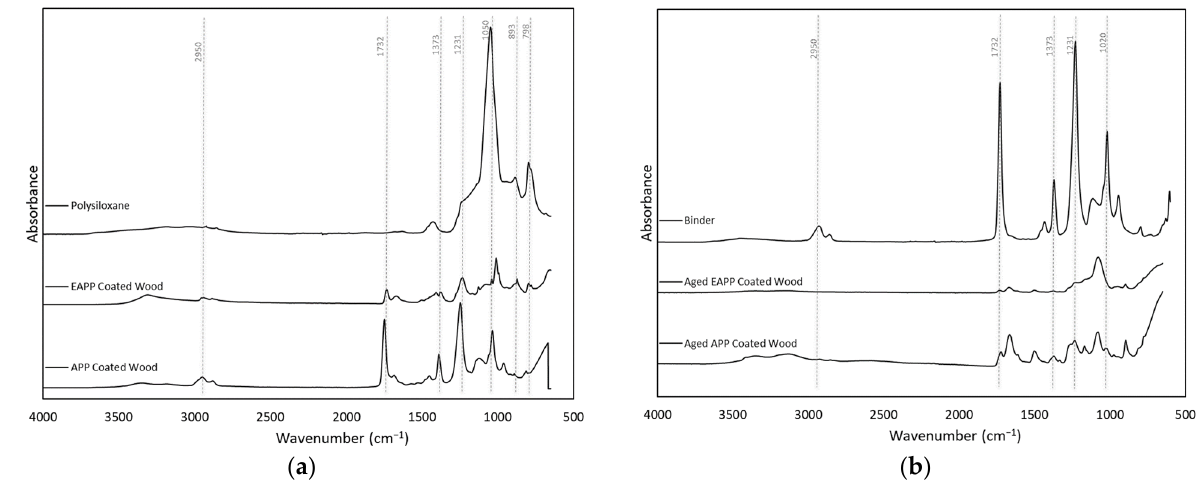
Figure 10. FTIR spectra for ( a ) polysiloxane shell and coated wood samples and ( b ) binder and aged coated wood samples. Table 6. FTIR peaks corresponding to their respective sources.